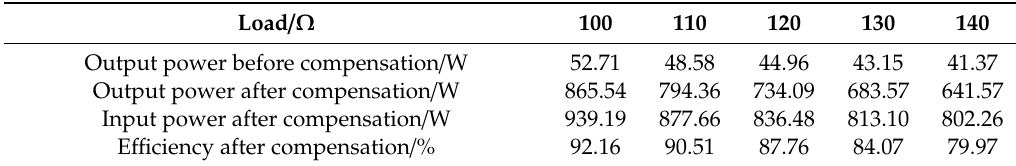
Table 3. Power and e ffi ciency after